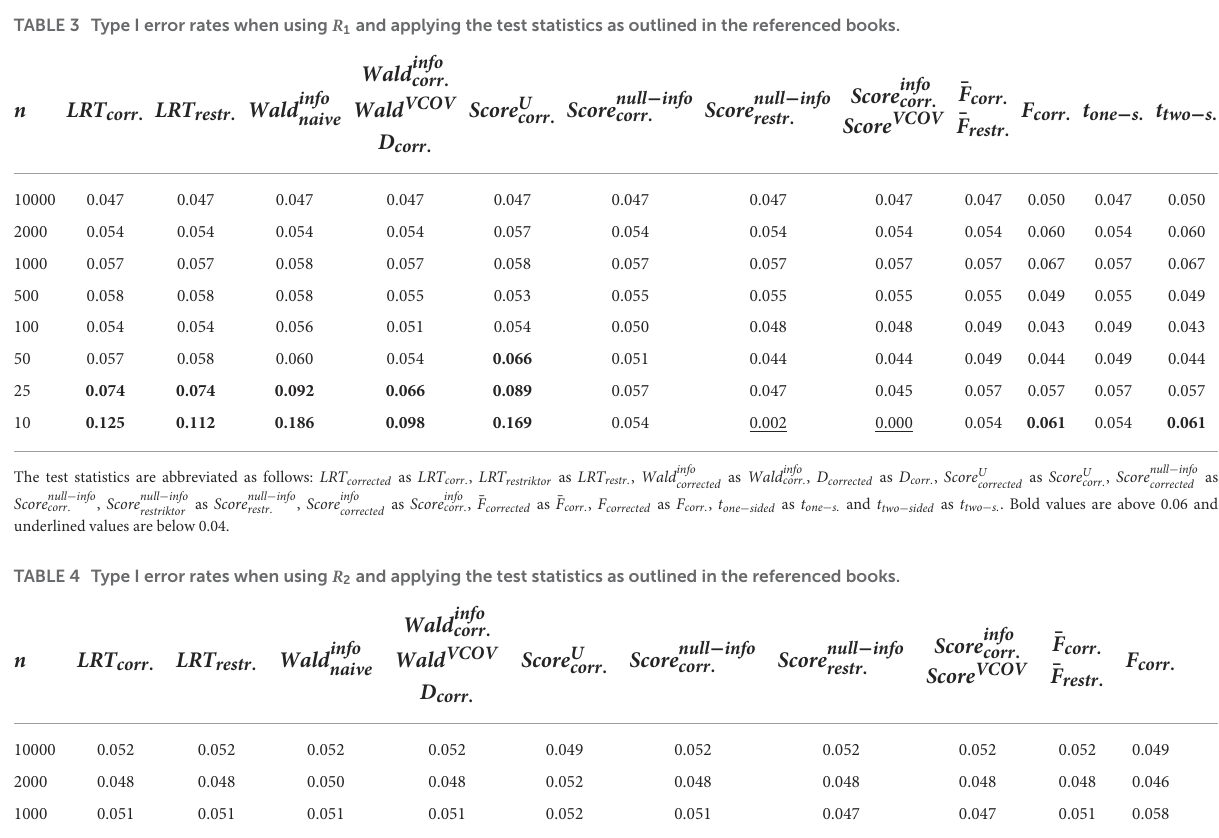
TABLE 3 Type I error rates when using R 1 and applying the test statistics as outlined in the referenced books.